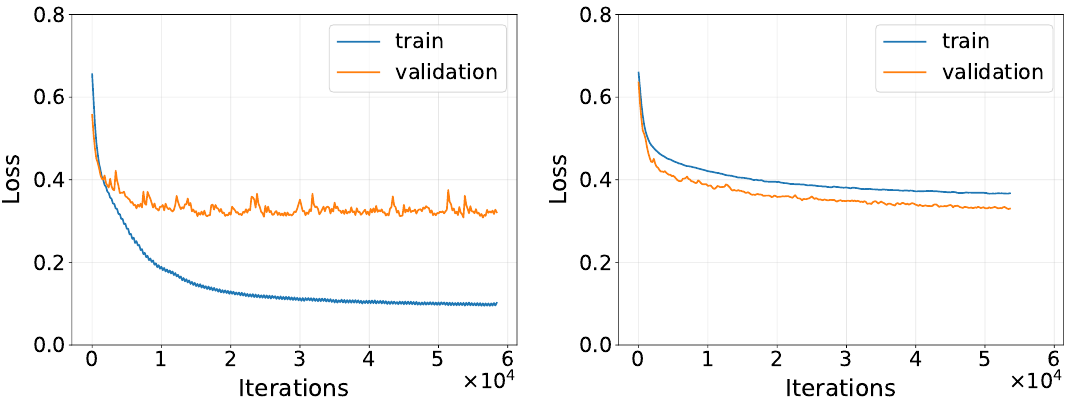
Figure 7 . Training and validation losses without (left) and with (right) the application of data augmentation to the training set. Overfitting in the left-hand plot is visible only after 1000 itera- tions. As the augmentation procedure is only relevant to the training phase, it was not applied to the validation set. The ability of the network to make correct predictions is improved for events unaltered by data augmentation, which explains why the loss is higher for the training set than for the validation set in the right-hand plot.